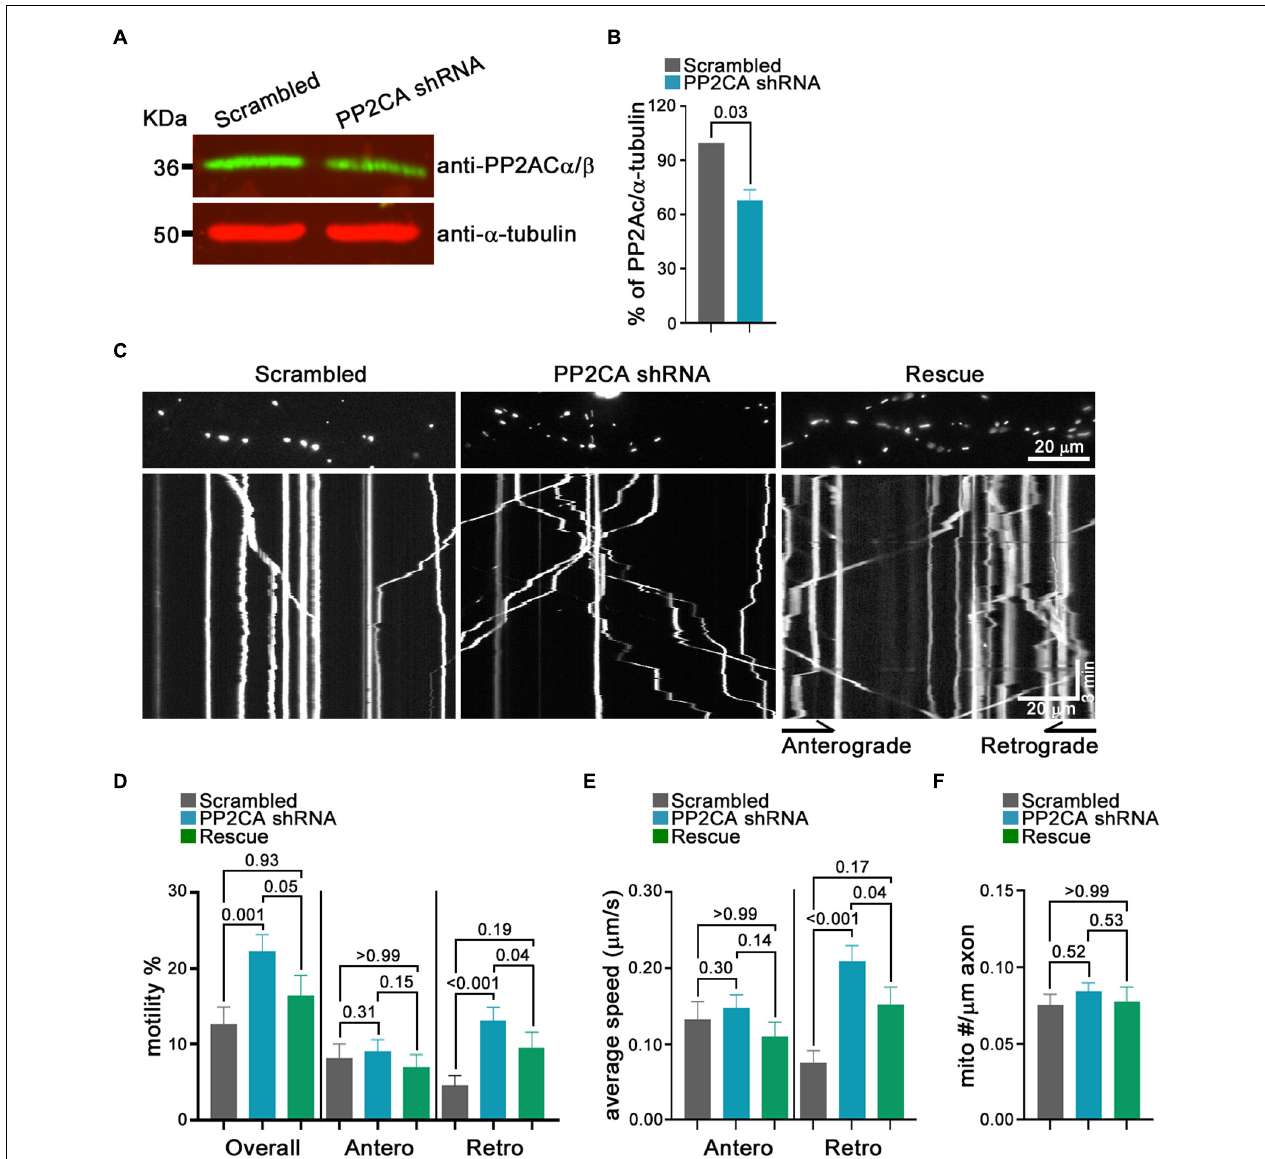
FIGURE 6 | Knockdown of the PP2A catalytic subunit increases retrograde transport of axonal mitochondria. (A) Representative Western blot of neurons transfected with shRNA against PP2AC or a scrambled shRNA and probed with anti-PP2Ac α / β (green) and anti- α -tubulin (red) demonstrates efficacy of the shRNA. (B) Quantification of PP2CA normalized to α -tubulin from Western blots as in (A) . N = 3, error bars represent mean ± SEM. (C–F) Kymograph analysis of mitochondrial transport in cortical axons expressing scrambled shRNA, PP2A shRNA, and an shRNA-resistant PP2A rescue construct. Representative kymograph images of mitochondria (C) and quantification of the percent of mitochondria that were motile, overall or in either anterograde or retrograde directions (D) , their average velocity (E) , and the density of mitochondria in axons for each condition (F) . Statistical comparisons to the scrambled shRNA are from nonparametric Kruskal–Wallis tests. All experiments were done in three independent cultures. A total of 19 axon segments (135 mitochondria) for scrambled shRNA, 25 axon segments (210 mitochondria) for PP2A shRNA, and 19 axon segments (137 mitochondria) for shRNA-resistant PP2A rescue neurons were analyzed. Each axon segment was selected from a separate neuron. Bars represent the average motility of all mitochondria analyzed for each condition. Error bars represent